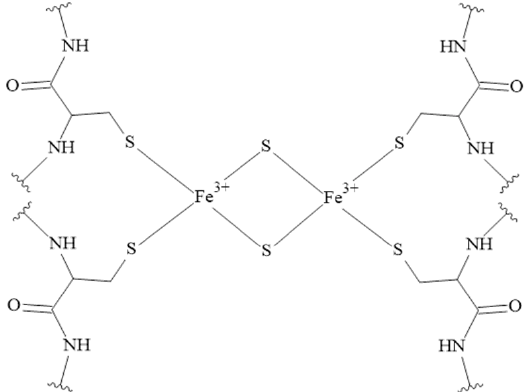
Figure 7. The structure of the rhombic 2Fe-2S cluster. The rhombic-form cluster exhibits two oxidation states: the oxidized status with two Fe 3+ , and the reduced status with one Fe 3+ and one Fe 2+ [157].